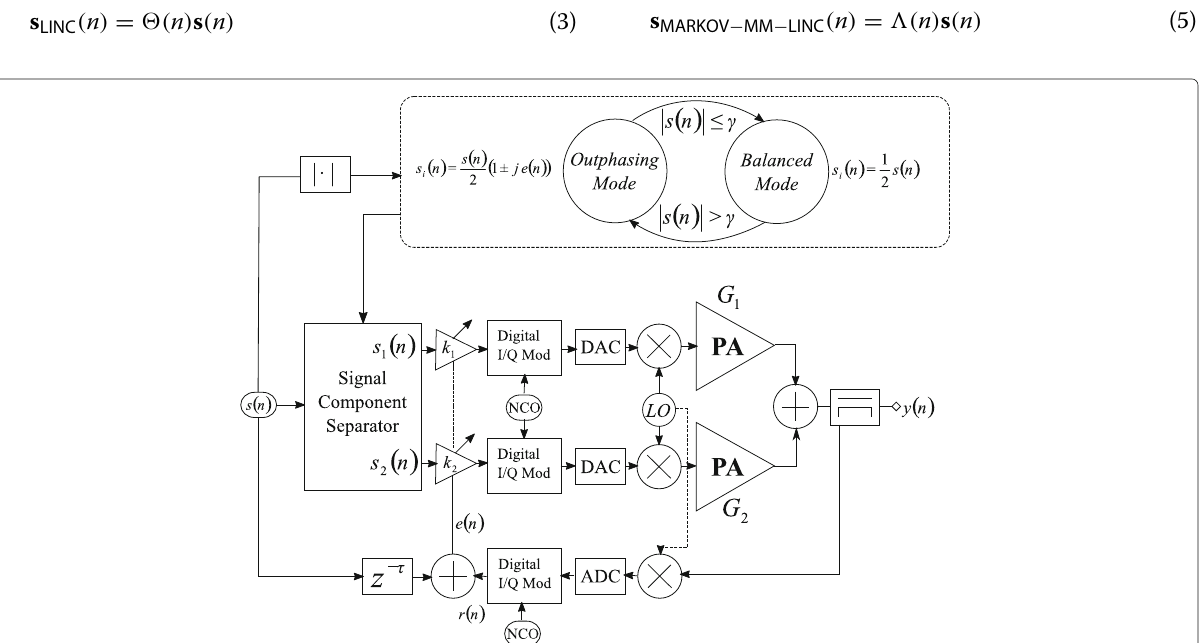
Fig. 1 General mode-multiplexing LINC architecture. The digital domain is carried out in a FPGA test-bench, whereas the remaining parts are analog